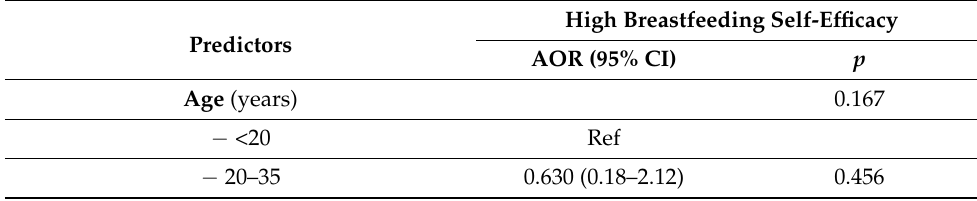
Table 4. Binary logistic regression analysis of high BSE